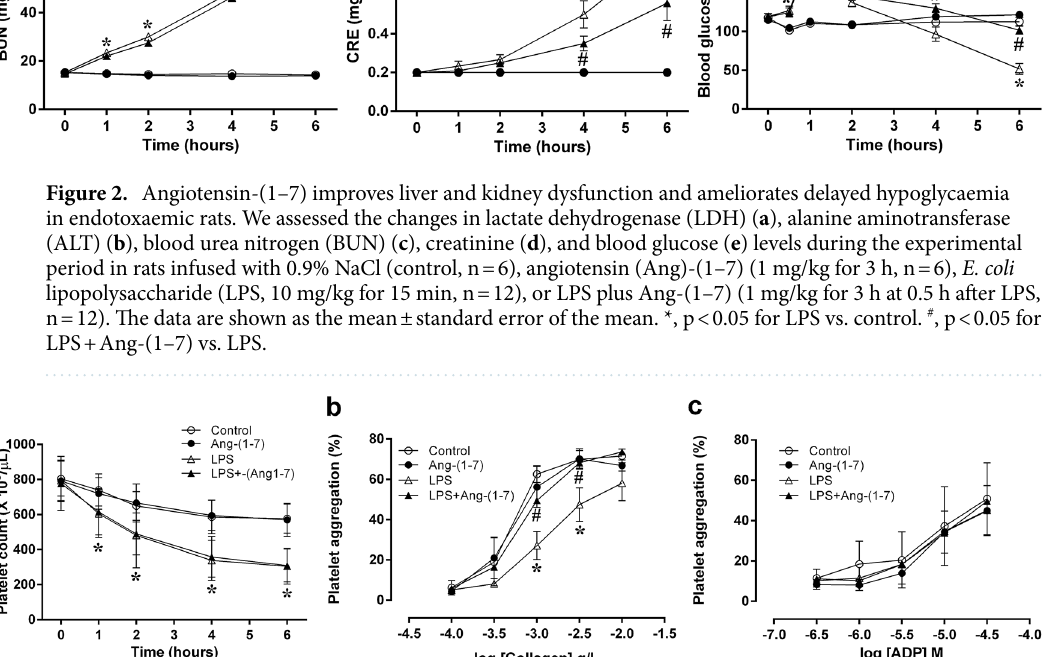
ment with Ang-(1–7) did not affect the platelet aggregation response curve activated by adenosine diphosphate (ADP) in the endotoxaemic rats compared to the control rats (Fig. 3c). Ang‑(1–7) attenuated LPS‑induced increases in plasma IL‑6 and NO. LPS significantly raised plasma IL-6 levels at 6 h post-administration (p < 0.001 vs. control group; Fig. 4a). This change was attenuated by Ang-(1–7) treatment (p = 0.001 vs. LPS group). In addition, LPS increased plasma NO levels with time (p < 0.001 vs. control group). The plasma NO increases at 4 and 6 h after LPS administration were also attenuated by Ang- (1–7) (at 4 h: p = 0.003 and at 6 h: p = 0.001 vs. LPS group; Fig. 4b). In lung and liver tissues, LPS also caused elevated NO levels in endotoxaemic rats (lung: p = 0.016 and liver: p = 0.016 vs. control group; Fig. 5a,b). Treat- ment with Ang-(1–7) attenuated the NO levels in tissues, and there was no significant difference of NO level between LPS + Ang-(1–7) and control group (Fig. 5a,b). As biomarkers of oxidative stress, the 4-hydroxynonenal (4-HNE) and protein carbonyl levels in lung and liver tissues were no significant differences among all groups (Fig. 5c–f).